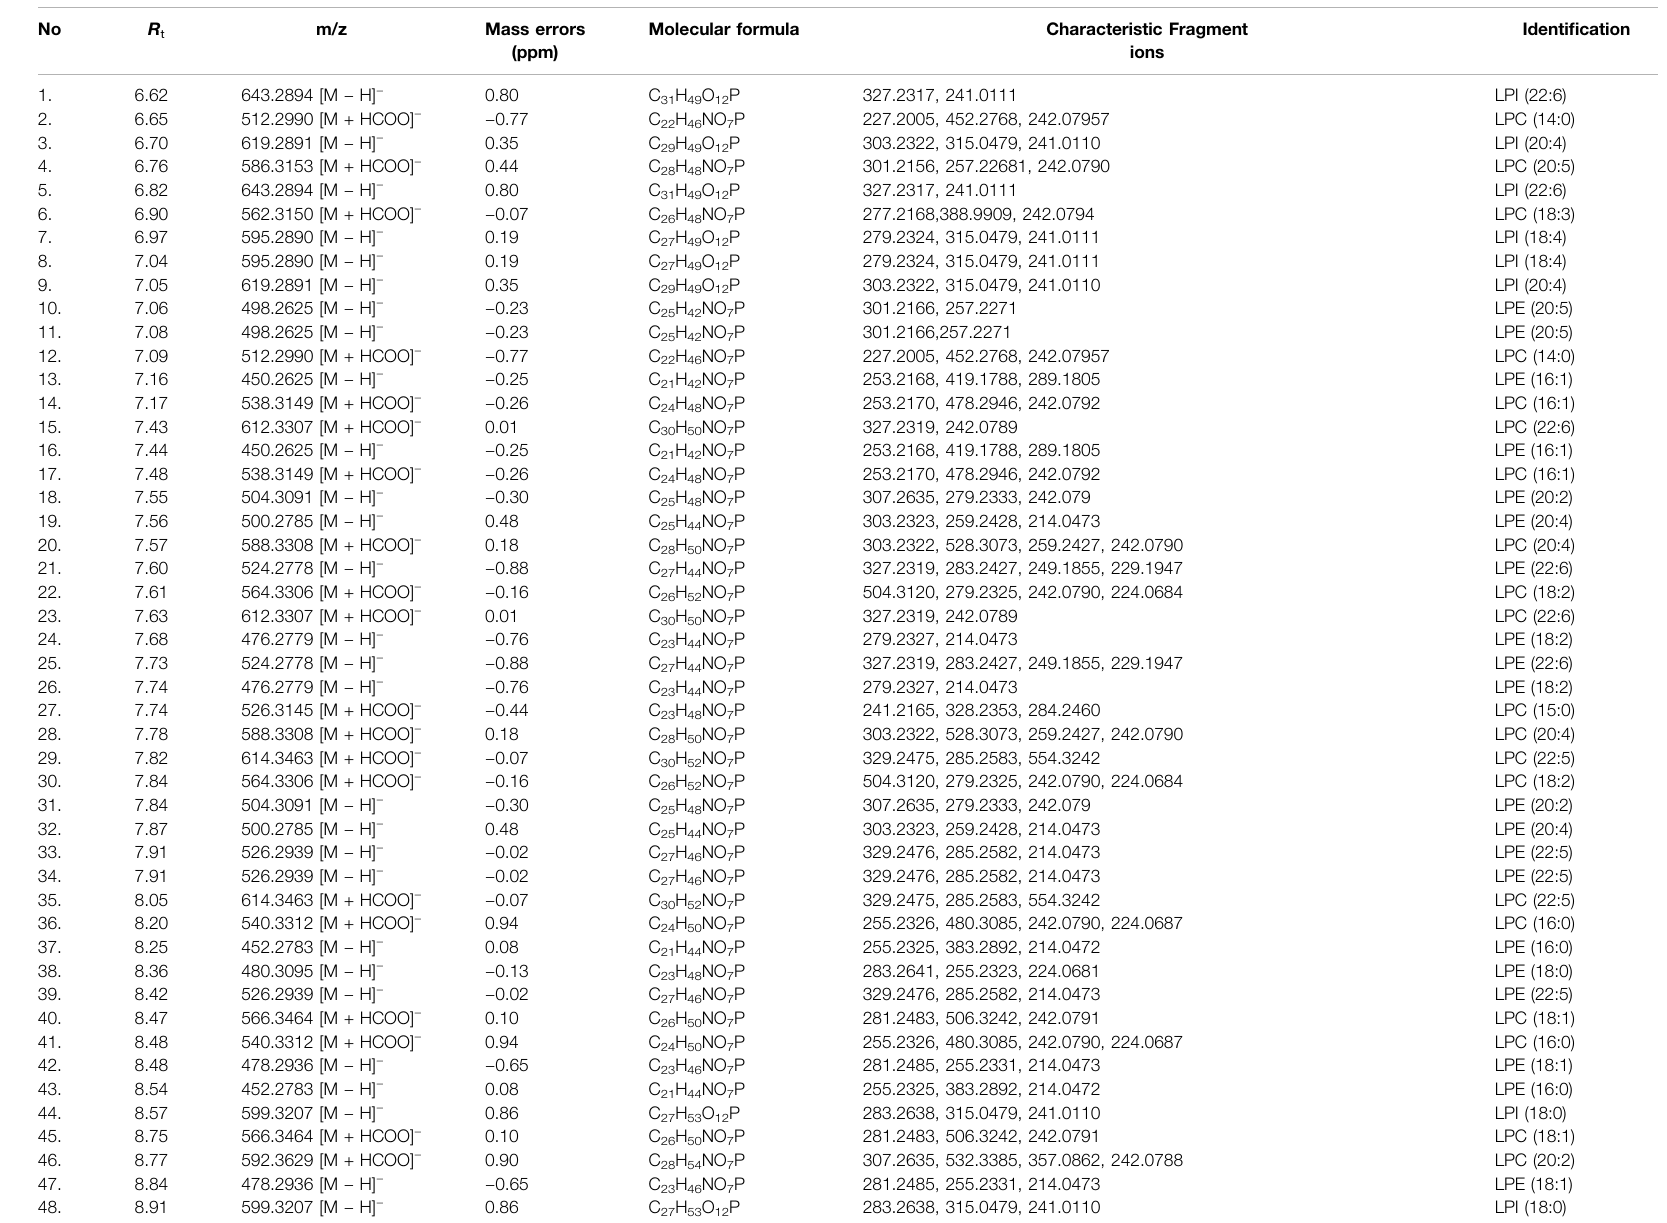
TABLE 2 | The detected and tentatively identi fi ed lipid molecules in the rat liver. No R t m/z Mass errors